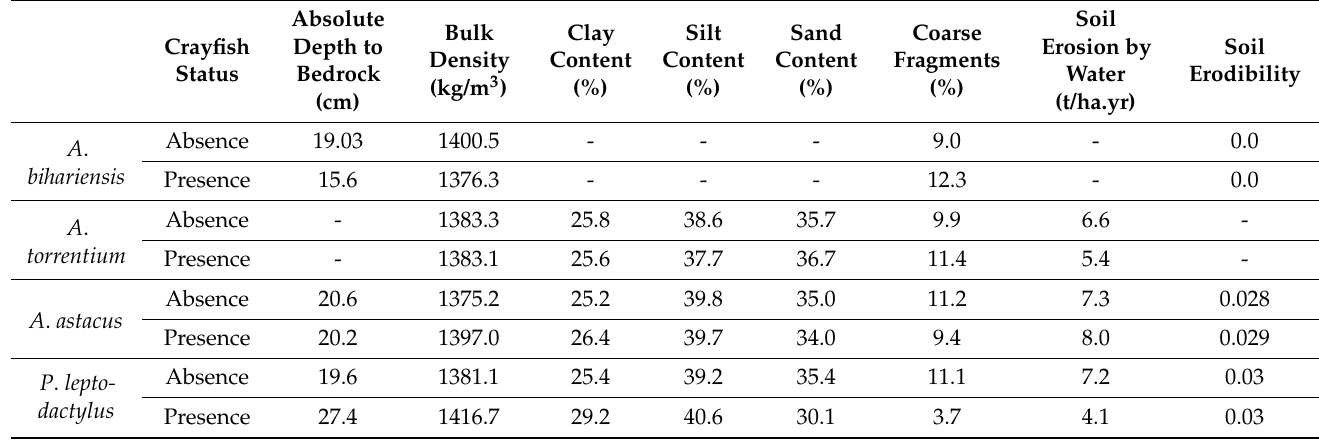
Table 1. Average values of the soil predictors for crayfish presence and absence locations.